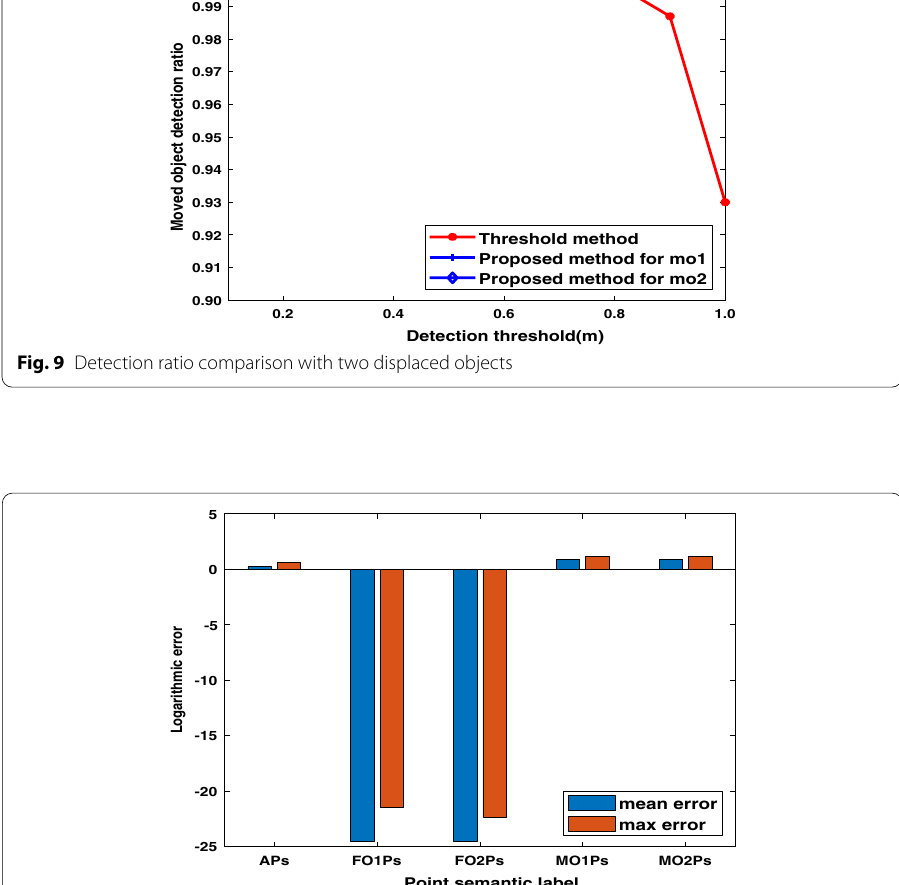
Fig. 10 Localization error under logarithmic level by EPnP with two displaced objects